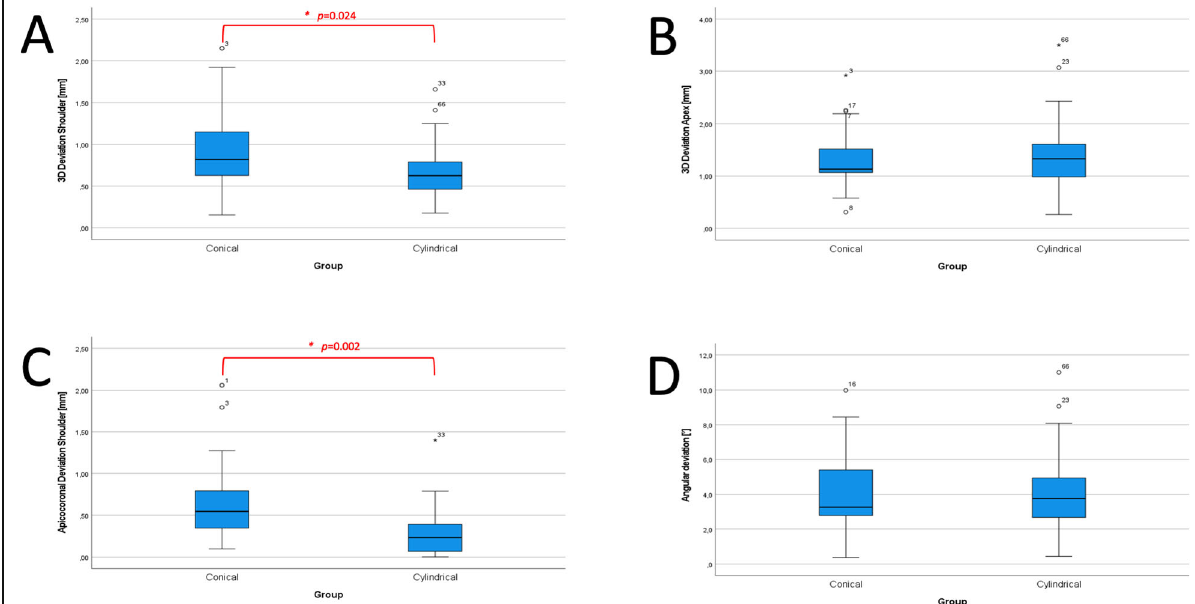
Fig. 3 Significant differences (*) observed between the groups with respect to the 3D deviations ( a ) and the apicocoronal distance ( c ) at the implant shoulder. There were no significant differences in the measurement of 3D deviation at the apex ( b ) and in angular deviation ( d